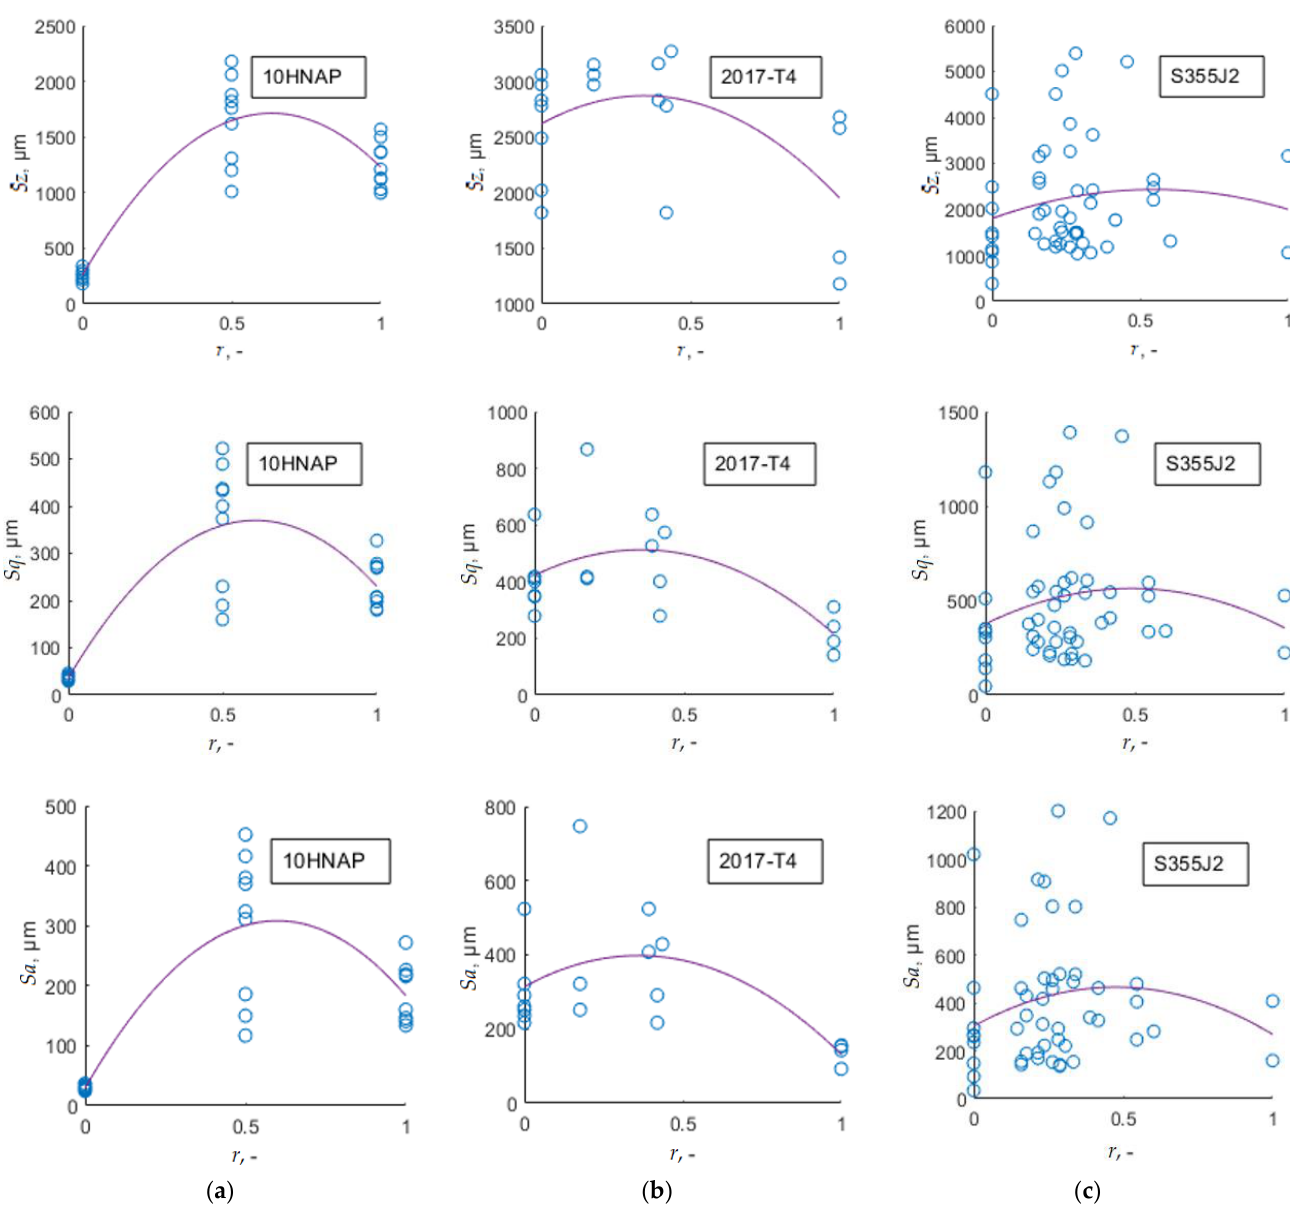
Figure 6. Areal surface parameters Sx ( Sz , Sq , Sa ) evaluation at different applied loading stress ratios of the r parameter for the investigated materials: ( a ) 10HNAP steel, ( b ) 2017-T4 aluminium alloy, and ( c ) S355J2 steel.